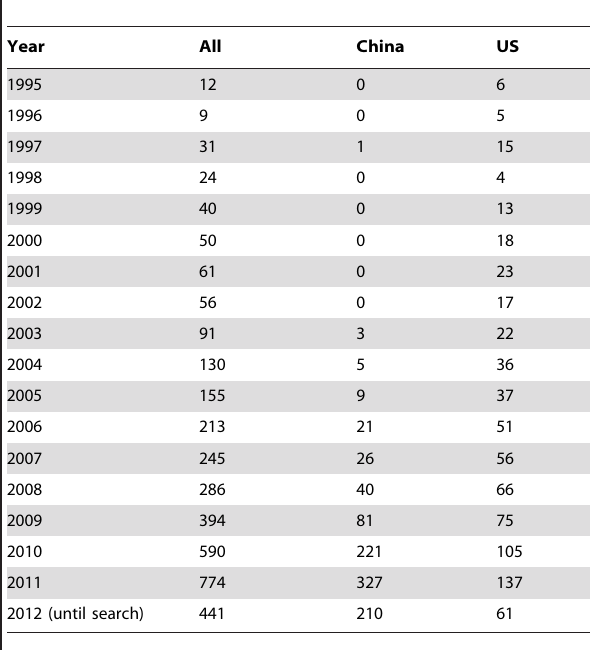
Table 3. Genetics-related